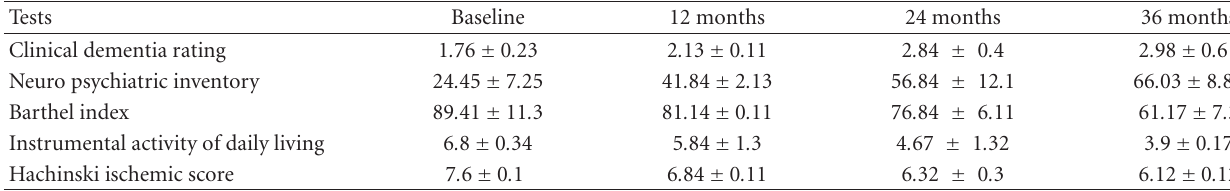
Table 4: Tests results in the patients observed during follow-up.